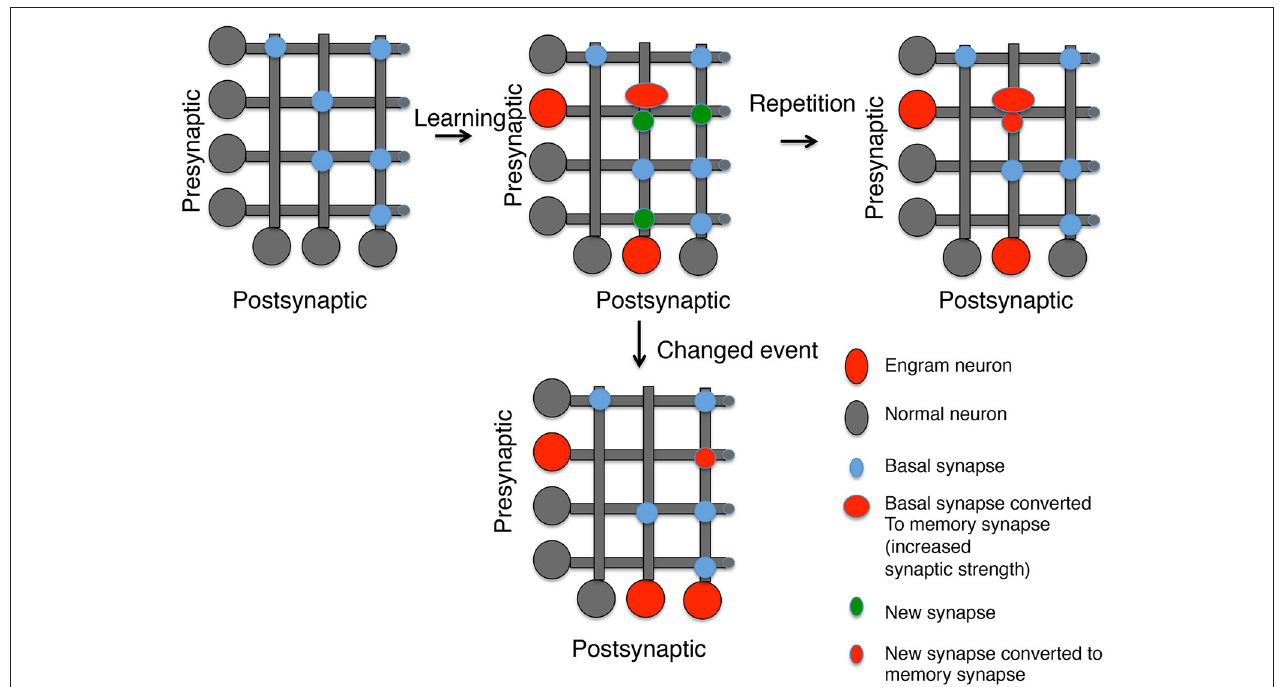
FIGURE 1 | Generating memory synapses. A set of neurons is presented with distributed basal synapses between presynaptic and postsynaptic pairs. An initial learning stimulus will (1) Allocate the memory to engram neurons (red somas); (2) Convert basal synapses between engram neurons to memory synapses with increased synaptic strength; and (3) Generate new synapses, both to neurons previously connected by synapses and neurons not connected. A repetition of the same learning stimulus can convert the new synapses into memory synapses between engram neurons, but new synapses between other neurons decay. However, a similar stimulus that is now paired with a different experience can lead to (1) Generation of new engram neurons; (2) the erasure of previous memory synapses, and (3) the conversion of new synapses between the old engram and new engram neuron into memory